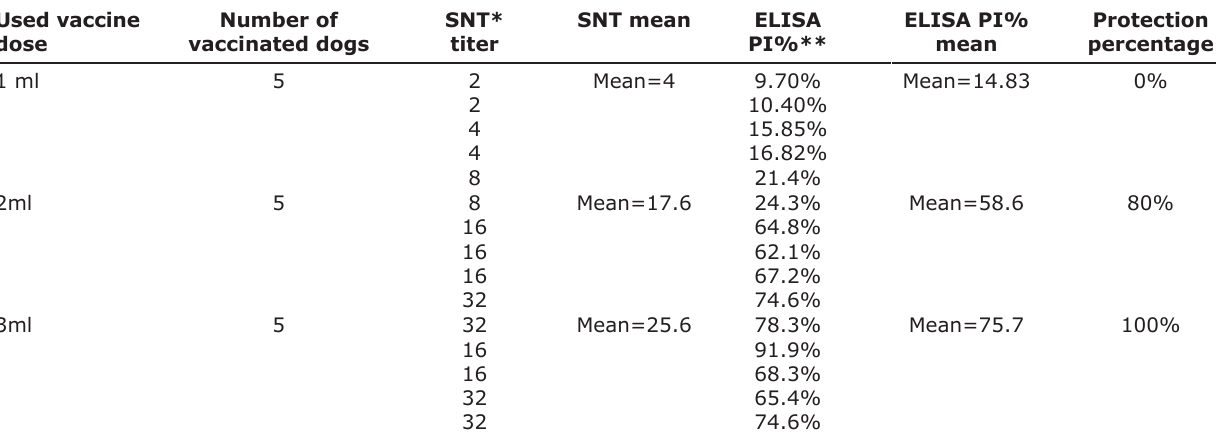
Table-1: Determination of the effective rabies oral vaccinal dose. Used vaccine dose